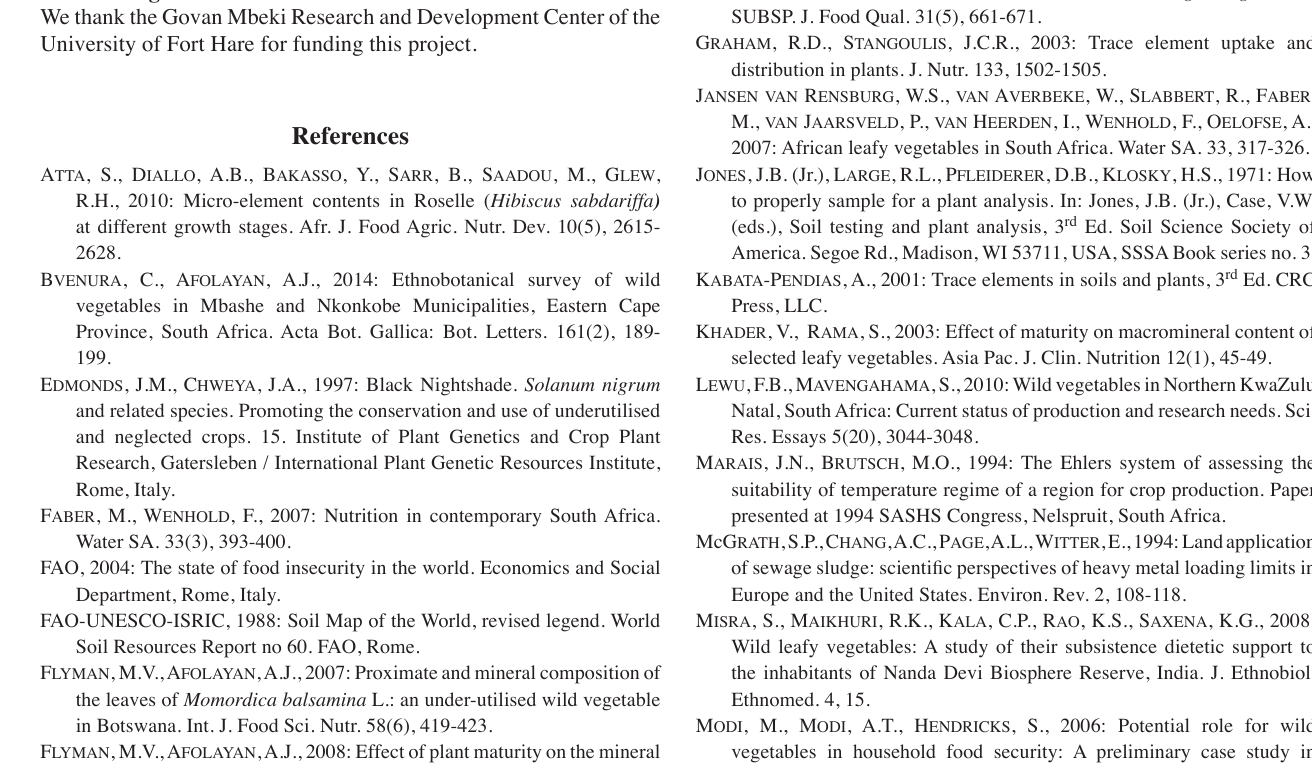
0 indicates readings taken at the time of transplanting Values shown are mean ± S.D. Means with different letters down the same column represent significant differences at p < 0.05.